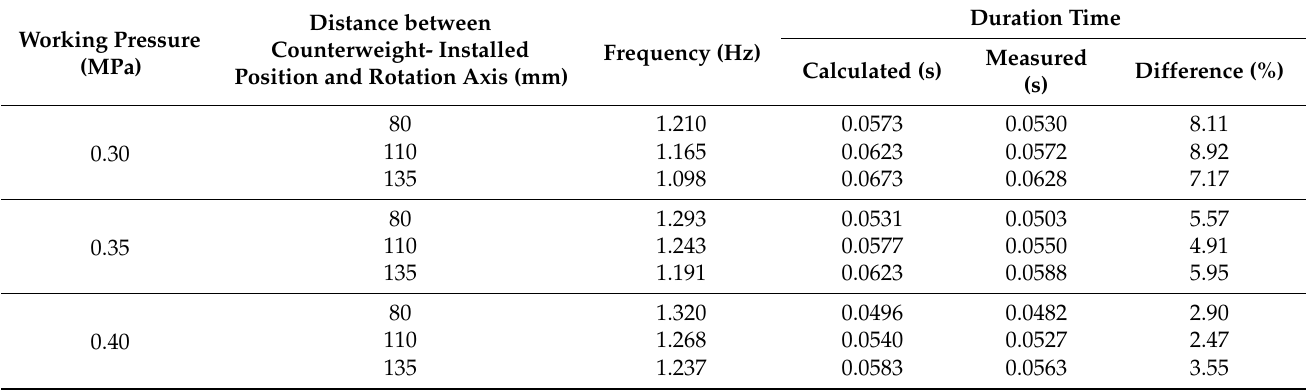
Table 2. Measured frequency, comparison between calculated values and measured values for the duration under different working pressures, and distance between counterweight-installed positions.